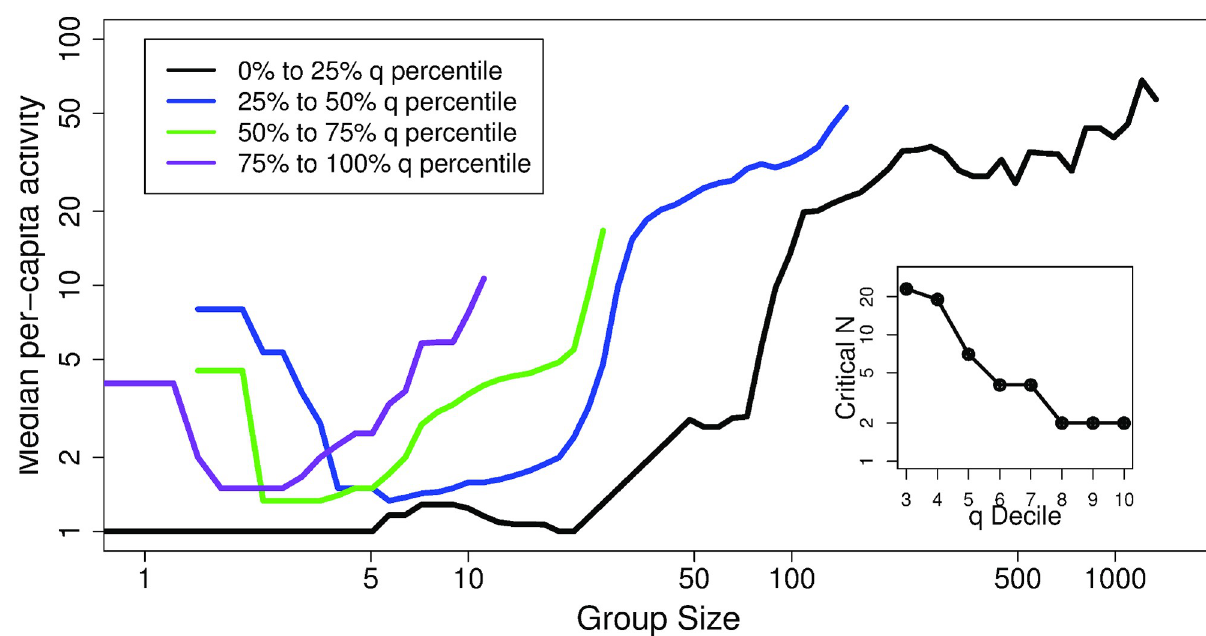
Fig 4. Activity median as a function of community size for communities grouped in four quartiles of response rate q (see legend for details). The inset shows, for a ten-fold partition of q values (deciles) the N crit as a function of within-decile q .